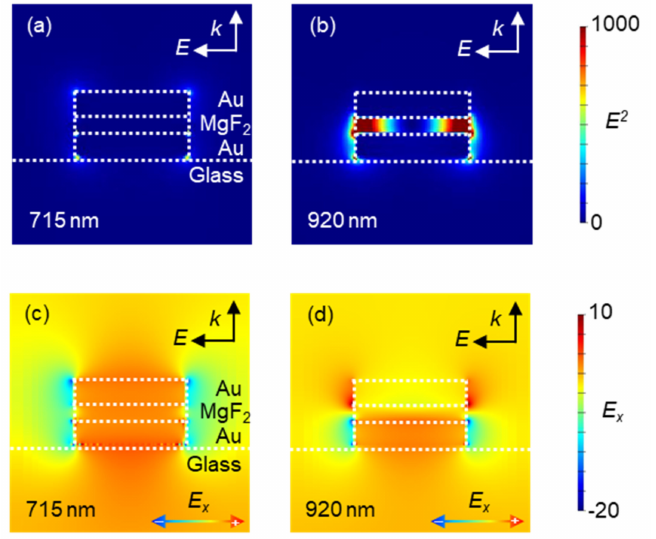
Figure 4. ( a , b ) Simulated electric field distributions generated around MIM nanostructures at ( a ) the 715 nm wavelength and ( b ) the 920 nm wavelength. The white arrows in the figures indicate the state of the electric field irradiated to the nanostructure to excite the LSP. ( c , d ) Simulated x-vector component of electric field distributions at ( c ) the 715 nm wavelength and ( d ) the 920 nm wavelength. The black arrows in the figures indicate the state of electric field irradiated to the nanostructure to excite the LSP, and the gradient arrows at the bottom of the figures show the correlation between the electric field vector and the